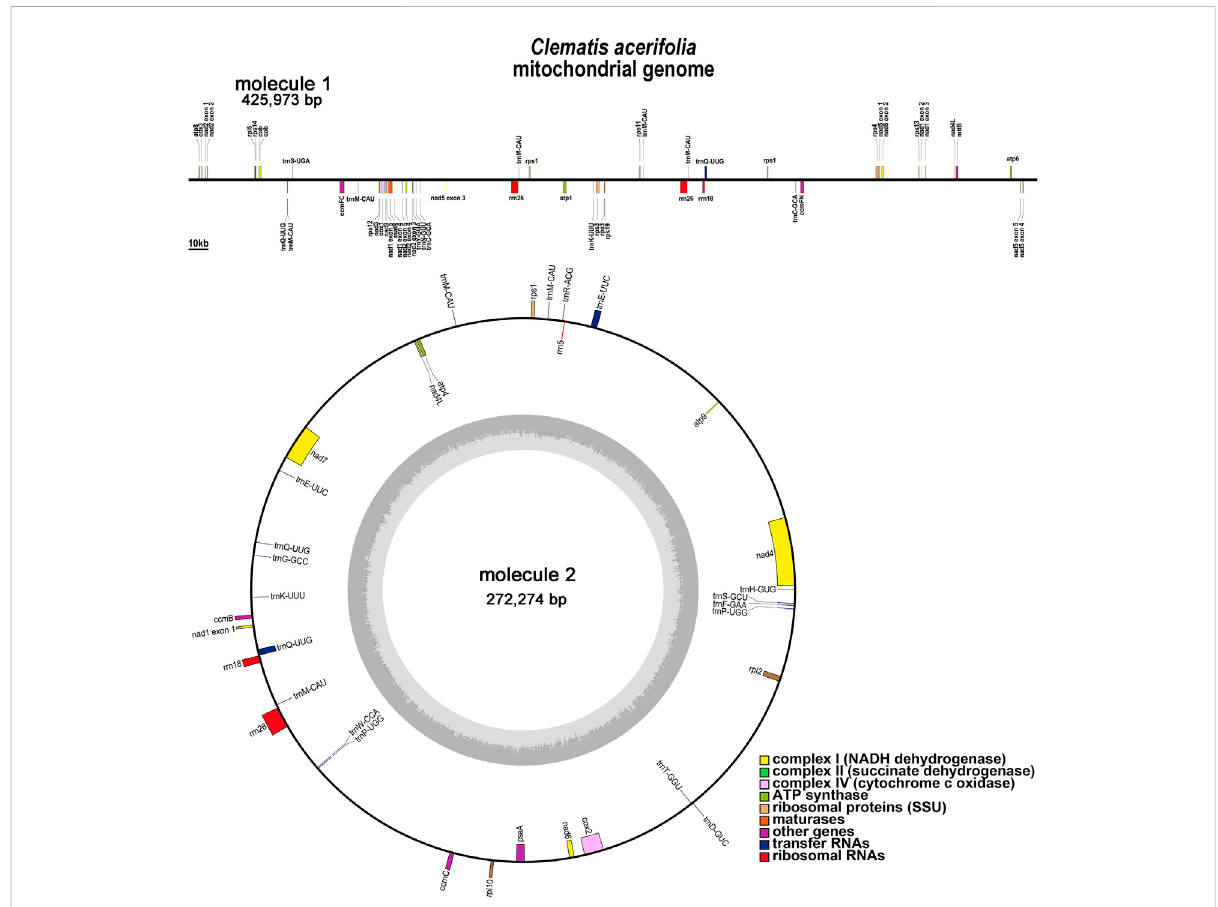
FIGURE 2 C. acerifolia mitogenome gene map. Genes shown on the outside and inside of the circle are transcribed clockwise andcounterclockwise, respectively. The dark gray region in the inner circle depicts GC